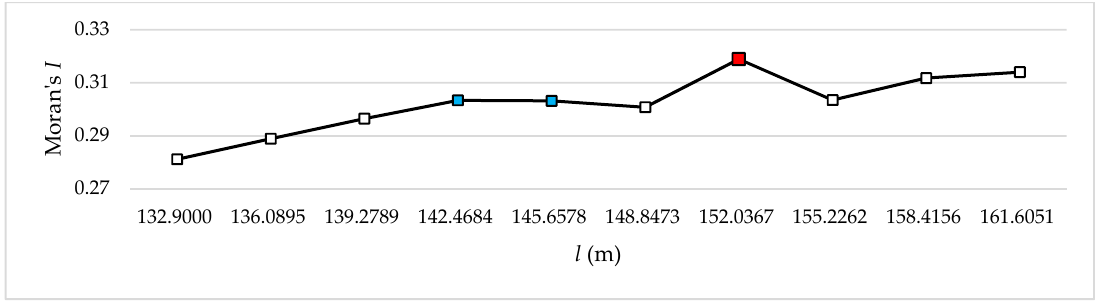
Figure 5. Changes of Moran’s I according to the cluster size at level 10.